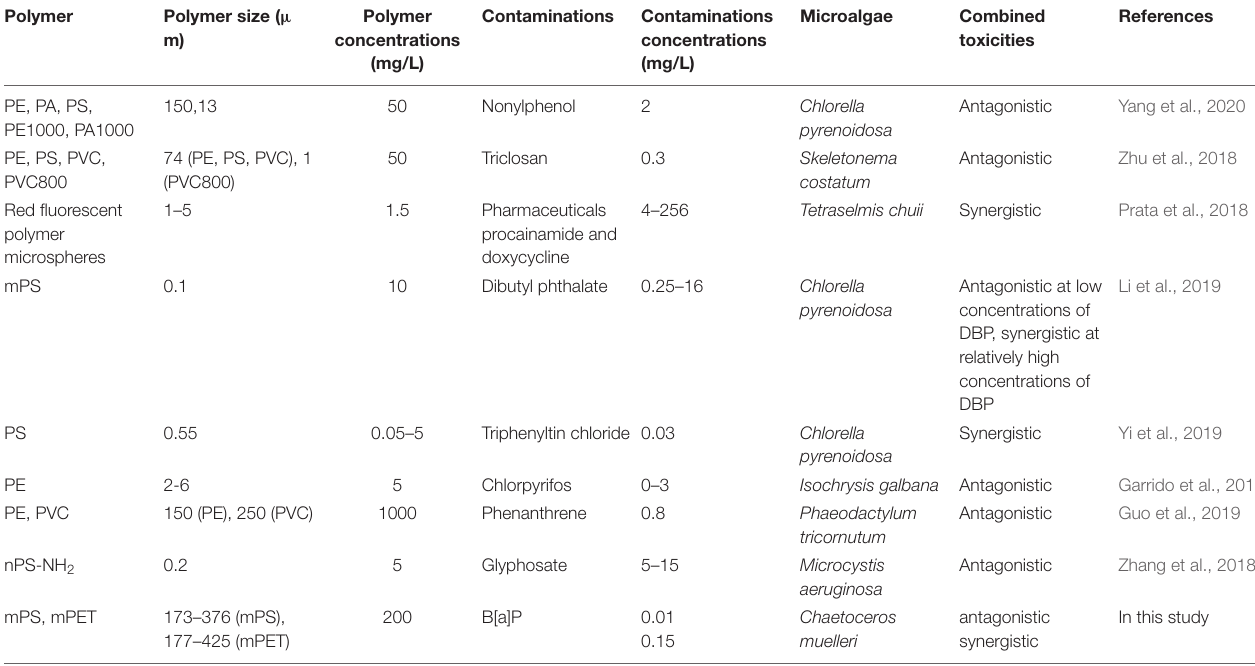
TABLE 4 | The combined toxicity influence of microplastics and organic pollutants on microalgae.